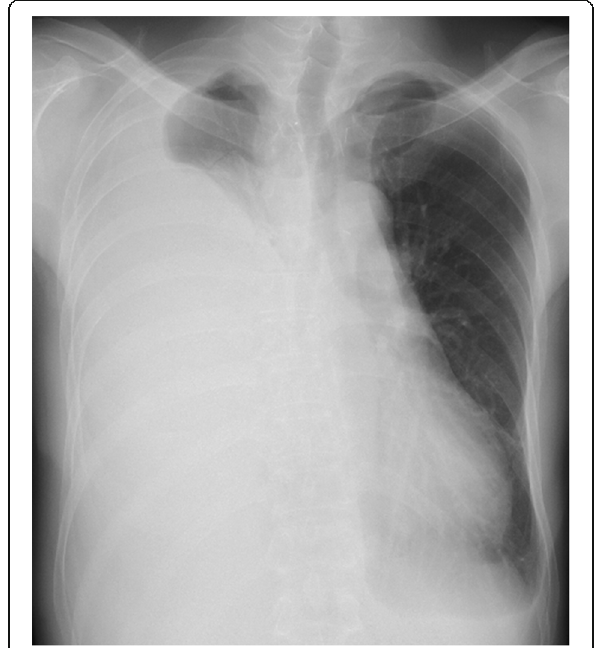
Fig. 1 Chest X-ray 1 month after operation revealed large amounts of right-sided pleural effusion